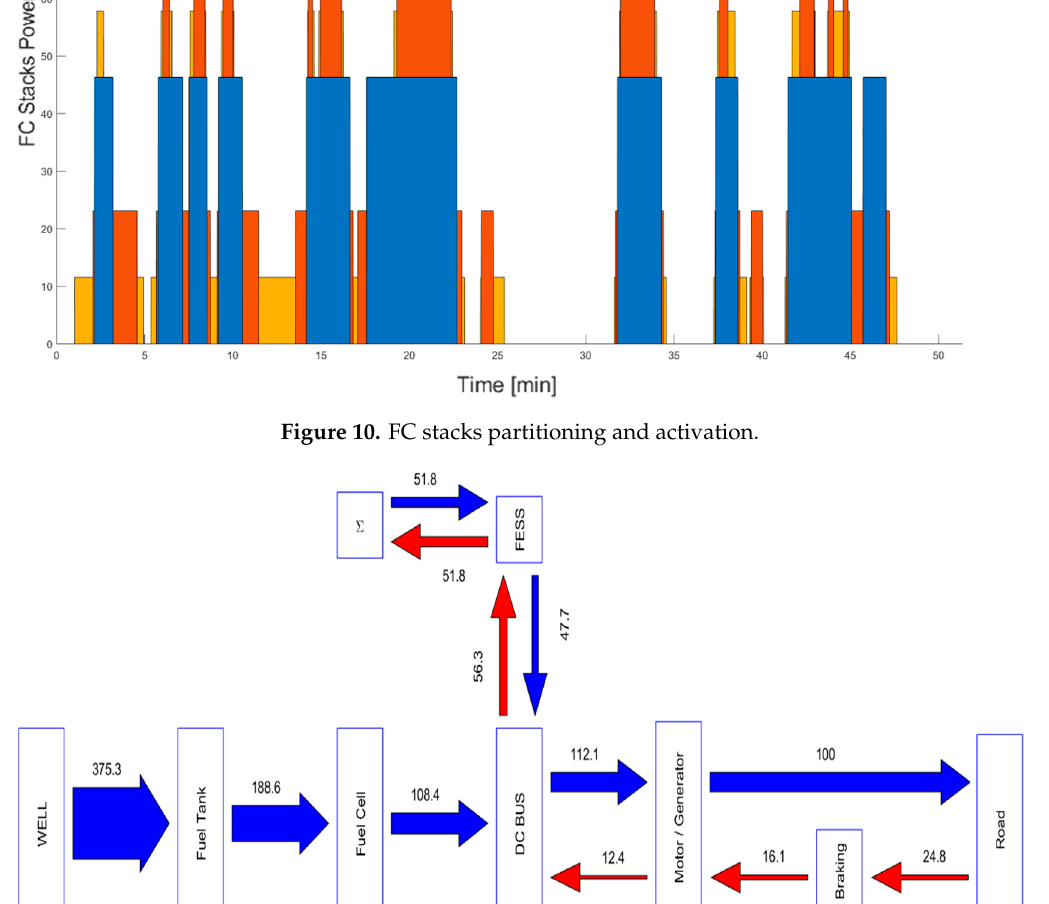
Figure 11. Vehicle energy balance (referred to 100 road energy output: 81.7 Wh/(km*ton)). Well-to- wheels (WTW) impact evaluated based on H 2 by CH4 production technologies, according to data from